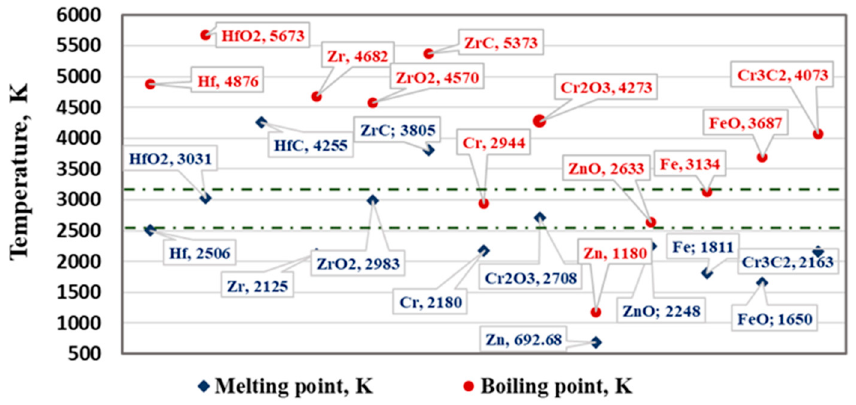
Figure 1. The melting and boiling temperatures of the studied metals and compounds.